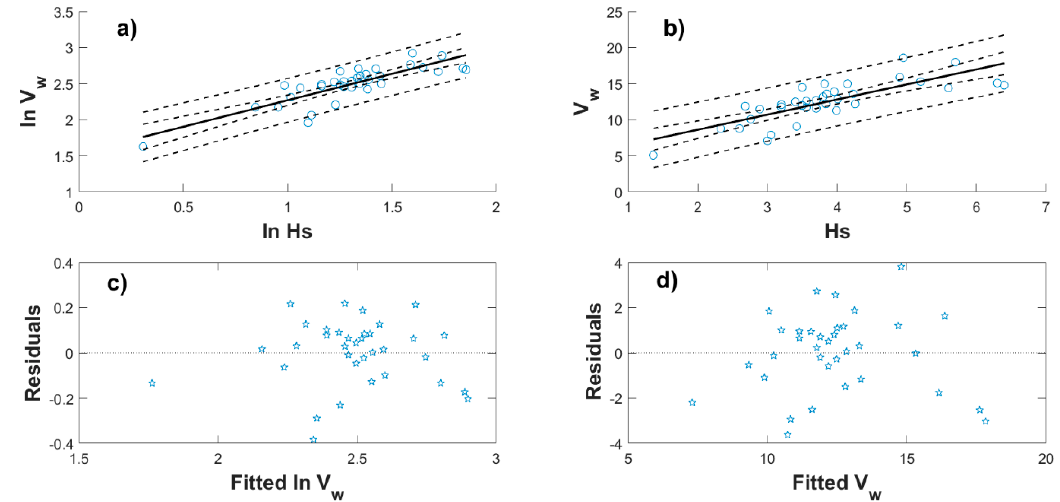
Figure 5. Regression and residual analysis by using ( a ) nonlinear (Equation (9)) and ( b ) linear (Equation (7)) models for February. Residuals using ( c ) Equation (9) and ( d ) Equation (7).